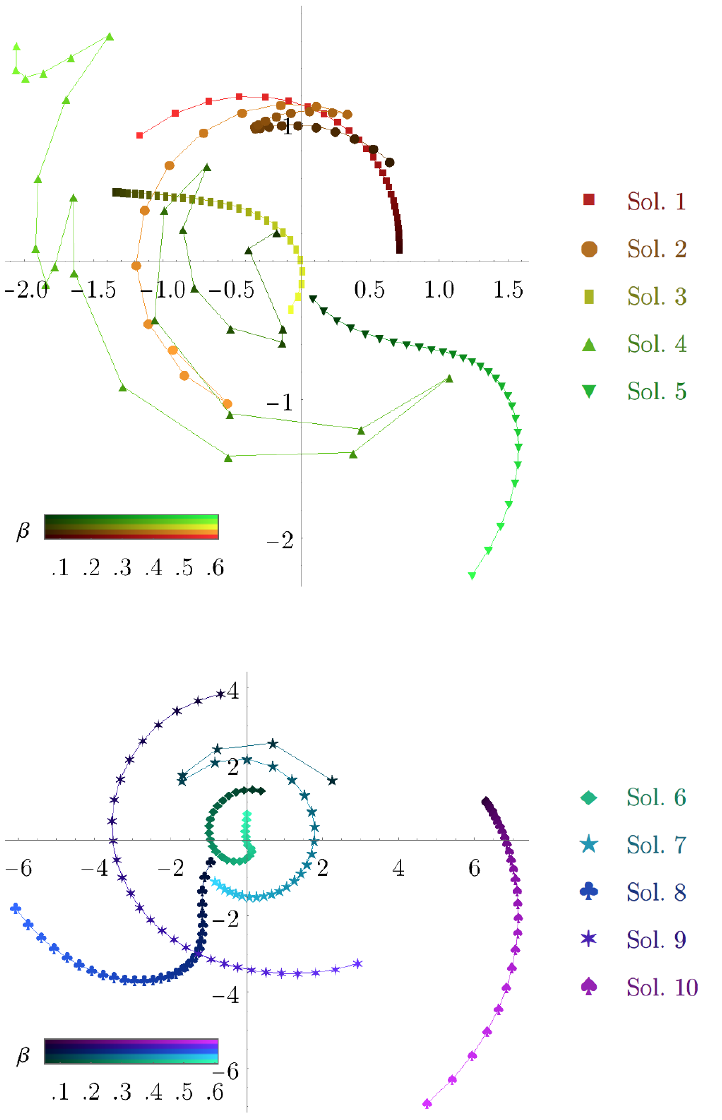
Figure 3 . The normalized overlaps (4.27) of the ten translationally invariant Bethe states with L = 8 and M = 4 plotted in the complex plane at k = 2. Once again, the color gradients from dark to brighter colors indicate the value of (cid:12) ranging from 0.05 to